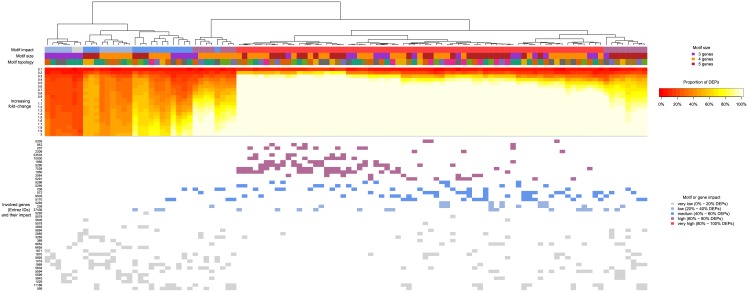
Effect of topological motifs in SPIA.Proportions of differentially expressed pathways (DEPs) for individual motifs (columns) at variable induced log2 fold-changes (rows) are displayed as a heatmap. Color bars on the top show influence of the motif, its size and topology (see S1 Text for details). Note, that colors used for motif topology are unique only among motifs of the same size. The bottom panel shows the influence of the genes in a representation of a topological motif as discovered in Experiment 3.